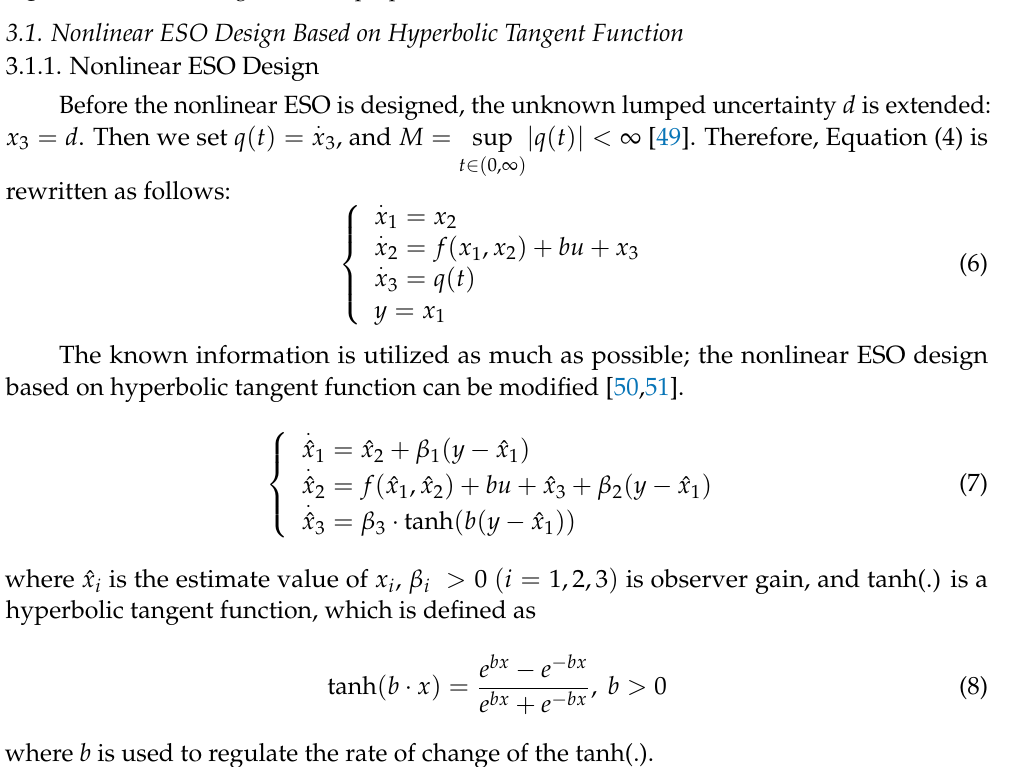
Figure 2. The block diagram of the proposed controller structure.